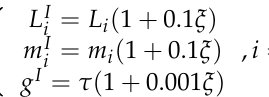
( b ) Figure 12. Lower bound of the double pendulum under a 1% uncertainty level: ( a ) lower bound of the rotation angle of the top rod; ( b ) lower bound of the rotation angle of the bottom rod. Further, considering the case that multiple interval parameters with large uncertainty levels are involved, five interval parameters were considered to propagate the uncertainty effect. The uncertain parameters were explicitly expressed as